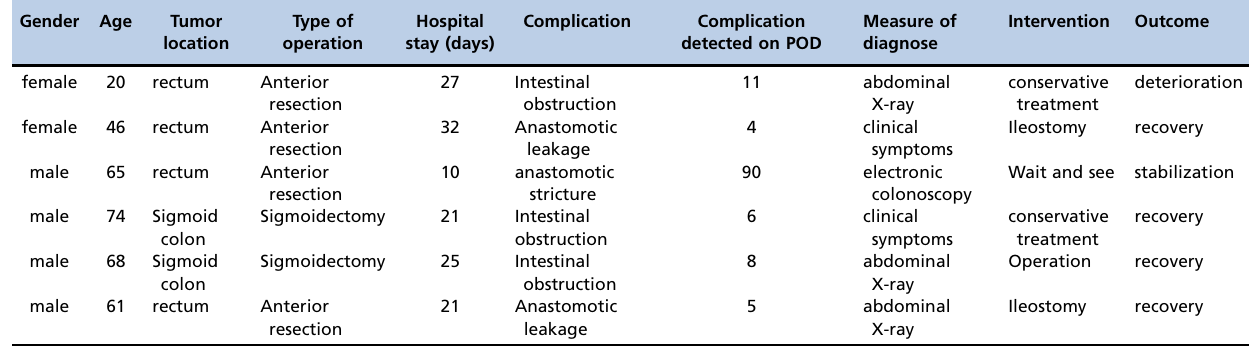
Table 4 - Detailed information on the total postoperative complications in the NiTi CAR 27 group. Gender